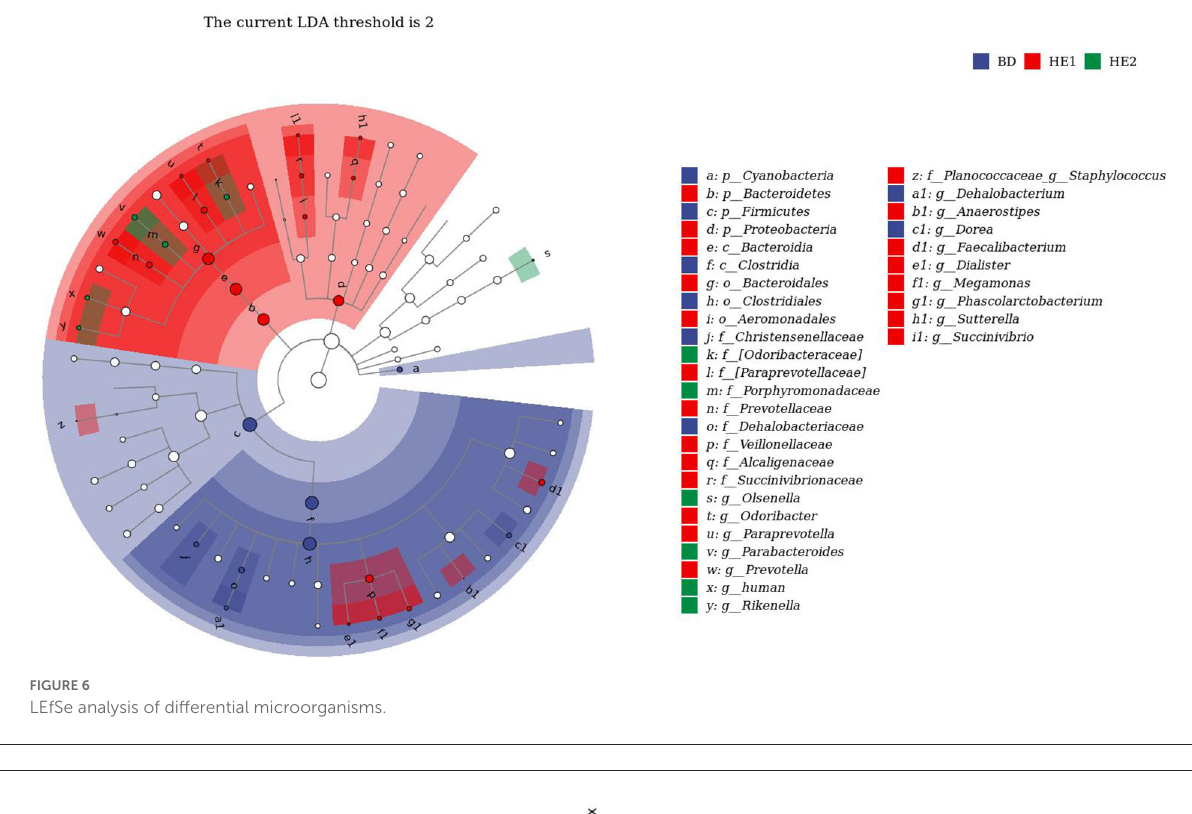
FIGURE6 LEfSe analysis of differential microorganisms.